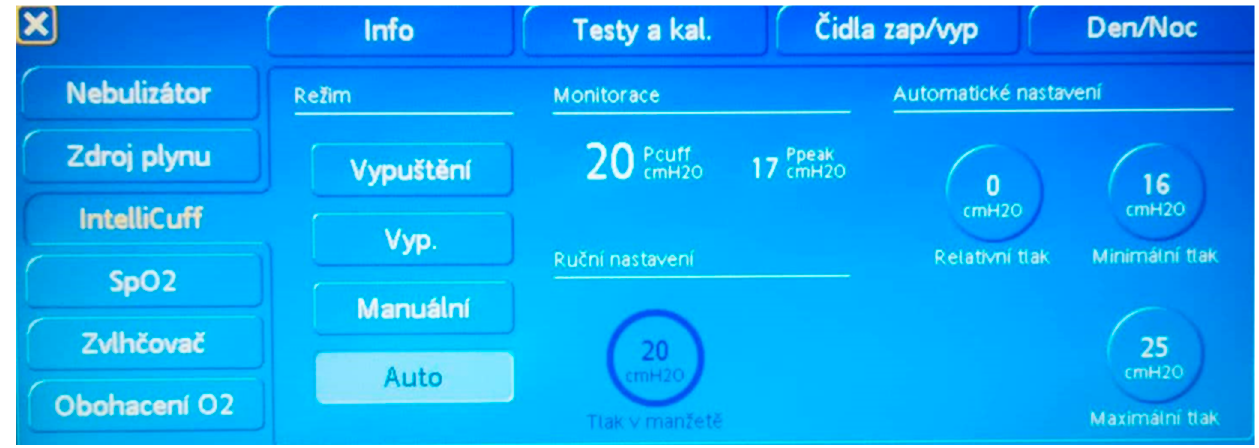
Figure 1 . IntelliCuff ® setting